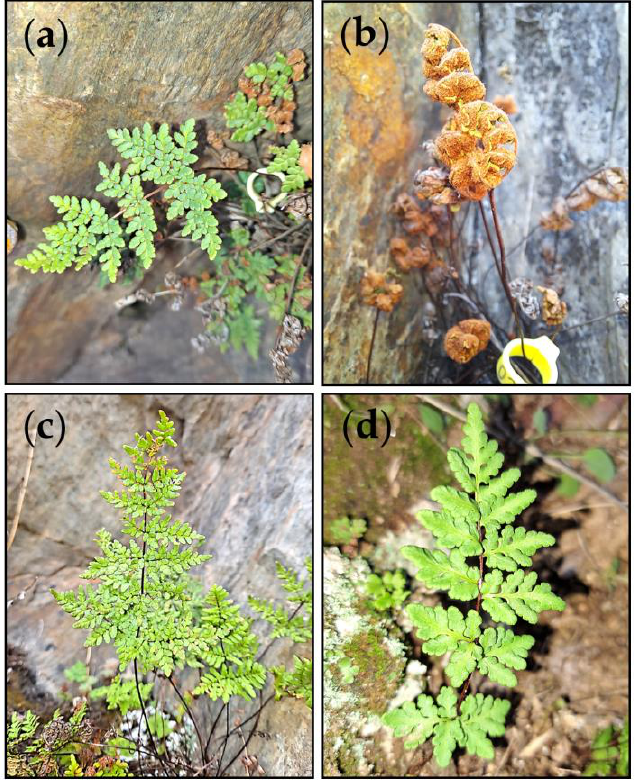
Figure 1. Leaves of the studied Oesporangium species: ( a ) O. hispanicum (HH), well hydrated; ( b ) HH, completely dry; ( c ) O. tinaei (HHPP), well hydrated; ( d ) O. pteridioides (PP), well